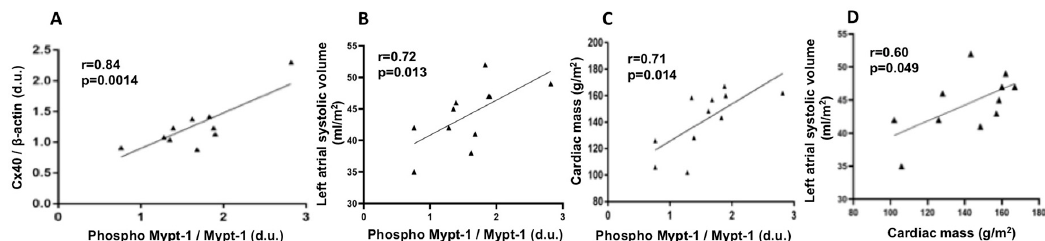
Figure 2. ( A ) Correlation analysis between phospho-MYPT-1 and Cx40 in DPAFs. ( B ) Correlation analysis between phospho-MYPT-1 and left atrial systolic volume. ( C ) Correlation analysis between phospho-MYPT-1 and cardiac mass. ( D ) Correlation analysis between cardiac mass and left atrial systolic volume in DPAFs.